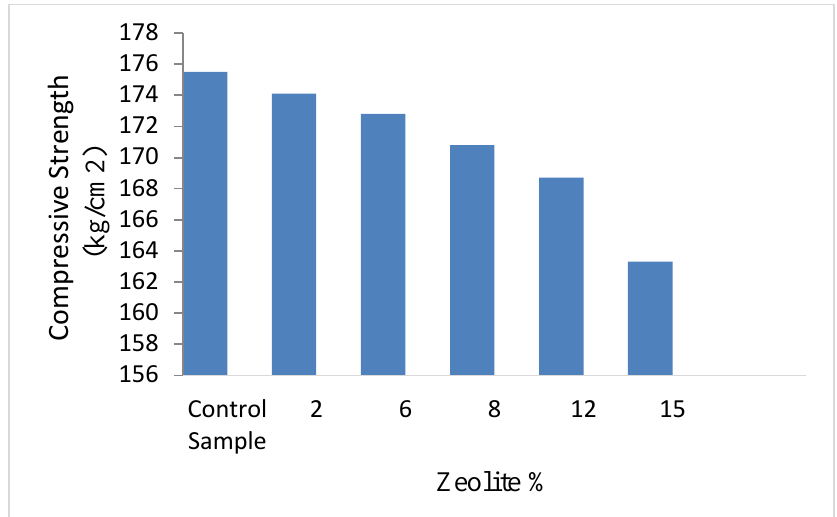
Fig. 11. Concrete strength with different percentages of Zeolite with 320 grade cement at the age of 7 days of concrete.